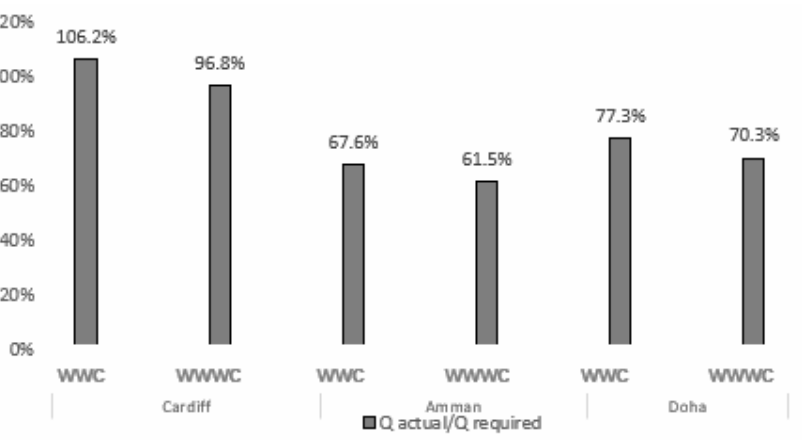
Figure 20. The actual-to-required ventilation ratio using Window-WindCatcher (WWC) and Without Window-WindCatcher (WWWC).